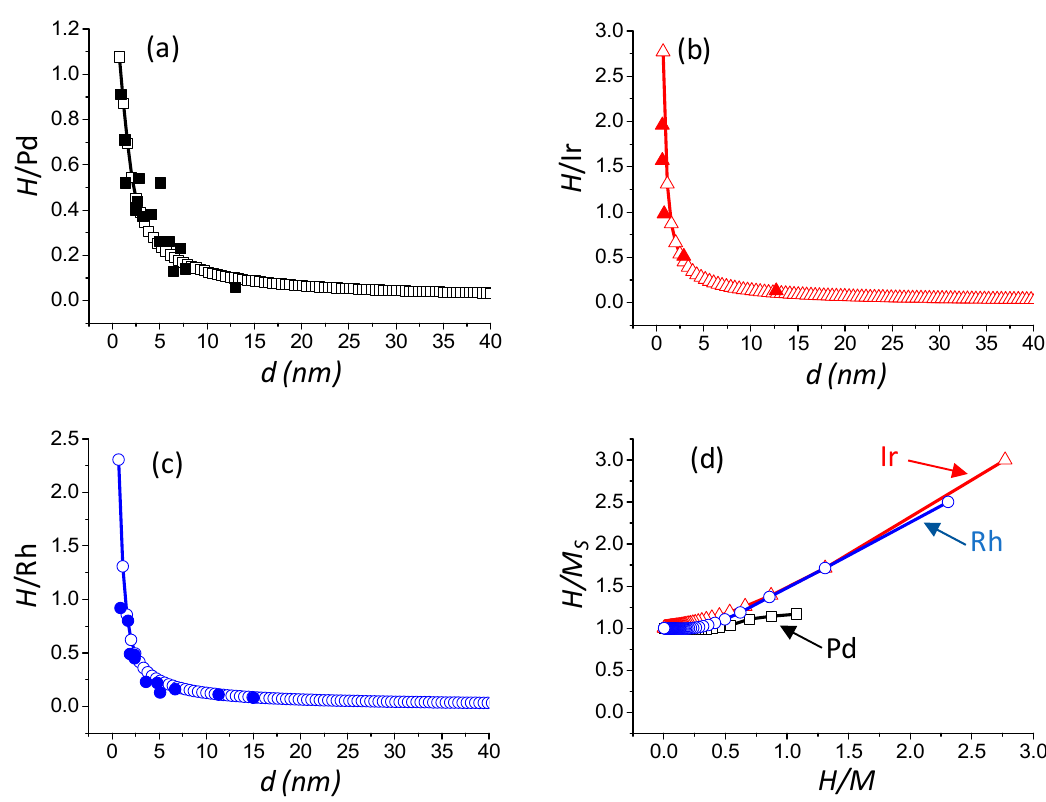
Figure 2. Evolution of the H/M ratio versus the particle size: M = Pd ( a ) , M = Ir ( b ) and M = Rh ( c ). Evolution of H/M S ratio versus H/M ratio ( d ). Full square, triangle, and circle: literature data for Pd, Ir, and Rh, respectively (see Table 3); and open square, triangle and circle: result of the statistical model calculation of this work for Pd, Ir, and Rh, respectively.